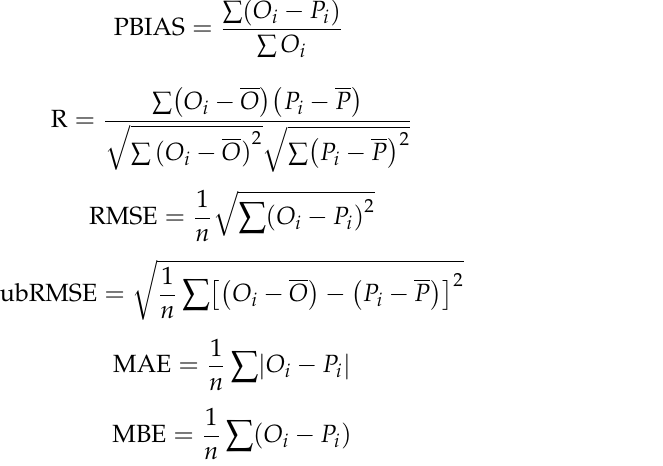
Barren and Sparse Grasslands and Savannas Vegetation Shrublands